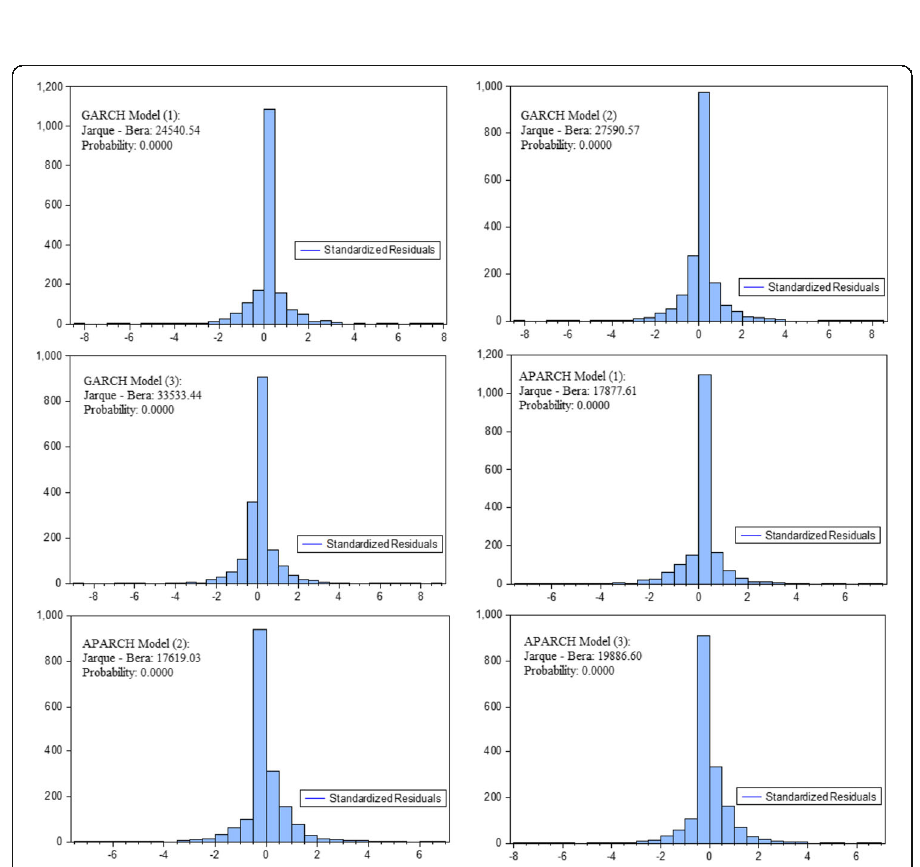
Fig. 3 Distribution of the error term in different models in Table